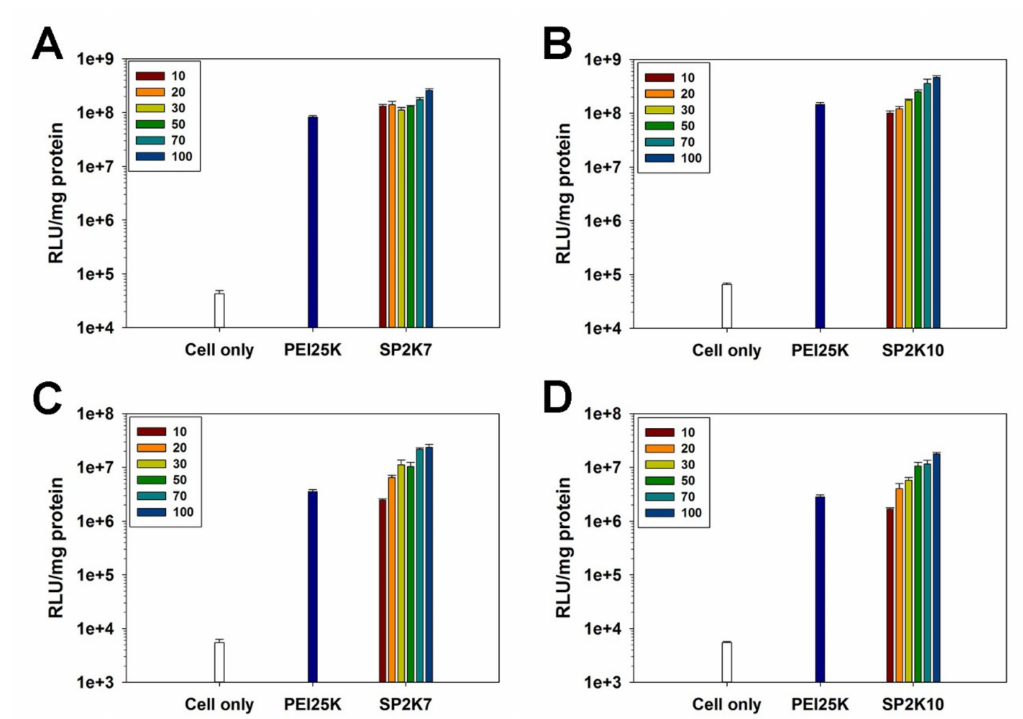
Figure 6. Transfection efficiency of ( A , C ) SP2K7 and ( B , D ) SP2K10 in HeLa cells. Transfection experiments were performed in ( A , B ) serum-free conditions and ( C , D ) serum conditions. Numbers in boxes indicate the weight ratios of the polyplexes. Error bars indicate the standard deviations ( n = 3).